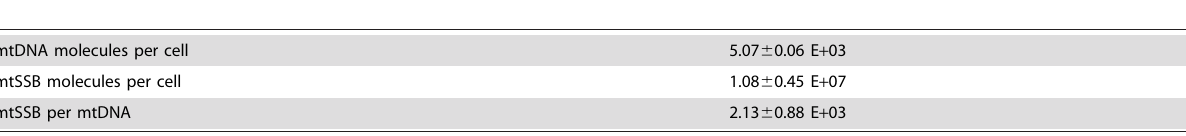
Table 1. Quantification of mtSSB to mtDNA ratio in HeLa cells.